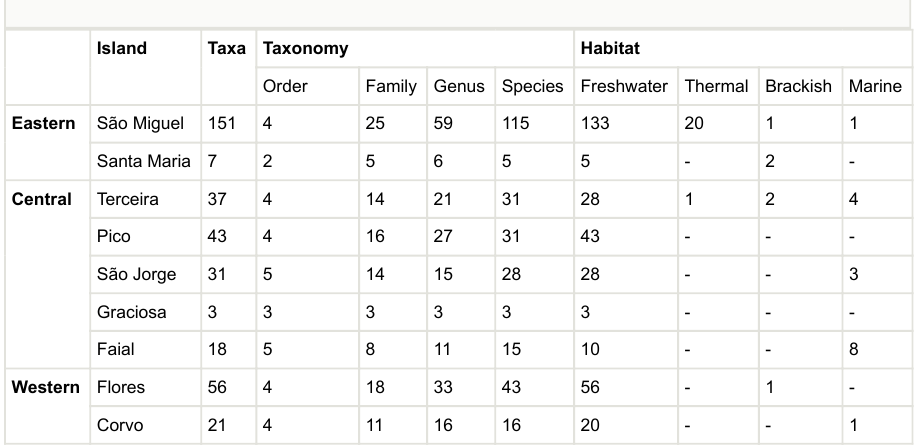
Figure 2. Species-area relationship. Regression line indicates a significant linear relationship with P = 2 0.003 and R = 0.86 (Pearson correlation). Dashed lines represent 95% interval confidence. COR: Corvo, FAI: Faial, FLO: Flores, GRA: Graciosa, PIC: Pico, SMR: Santa Maria, SJG: São Jorge, SMG: São Miguel, TER: Terceira. A summary of cyanobacteria species richness found in the Azores and on each of the nine islands in the different types of habitats is given in Table 5. The number of recorded species was highest on São Miguel Island (115) and lowest on Graciosa Island (3). Freshwater systems were the most diverse habitats, comprising 193 taxa (85.7%), followed by thermal, with 23 species (10.2%), marine (13 species, 5.8%) and brackish systems (3 species, 1.3%). Table 5. Cyanobacteria taxa richness in the Azores by